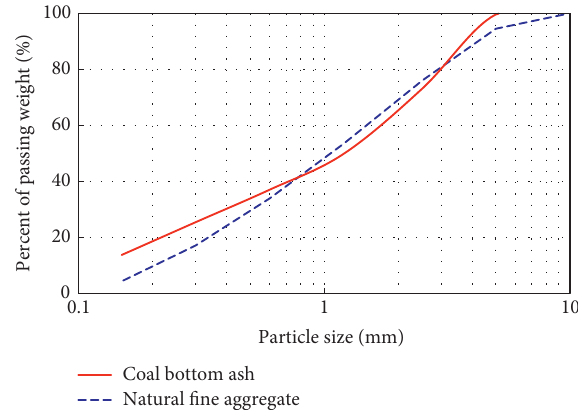
Figure 2: Grading curves of the CBA and natural fine